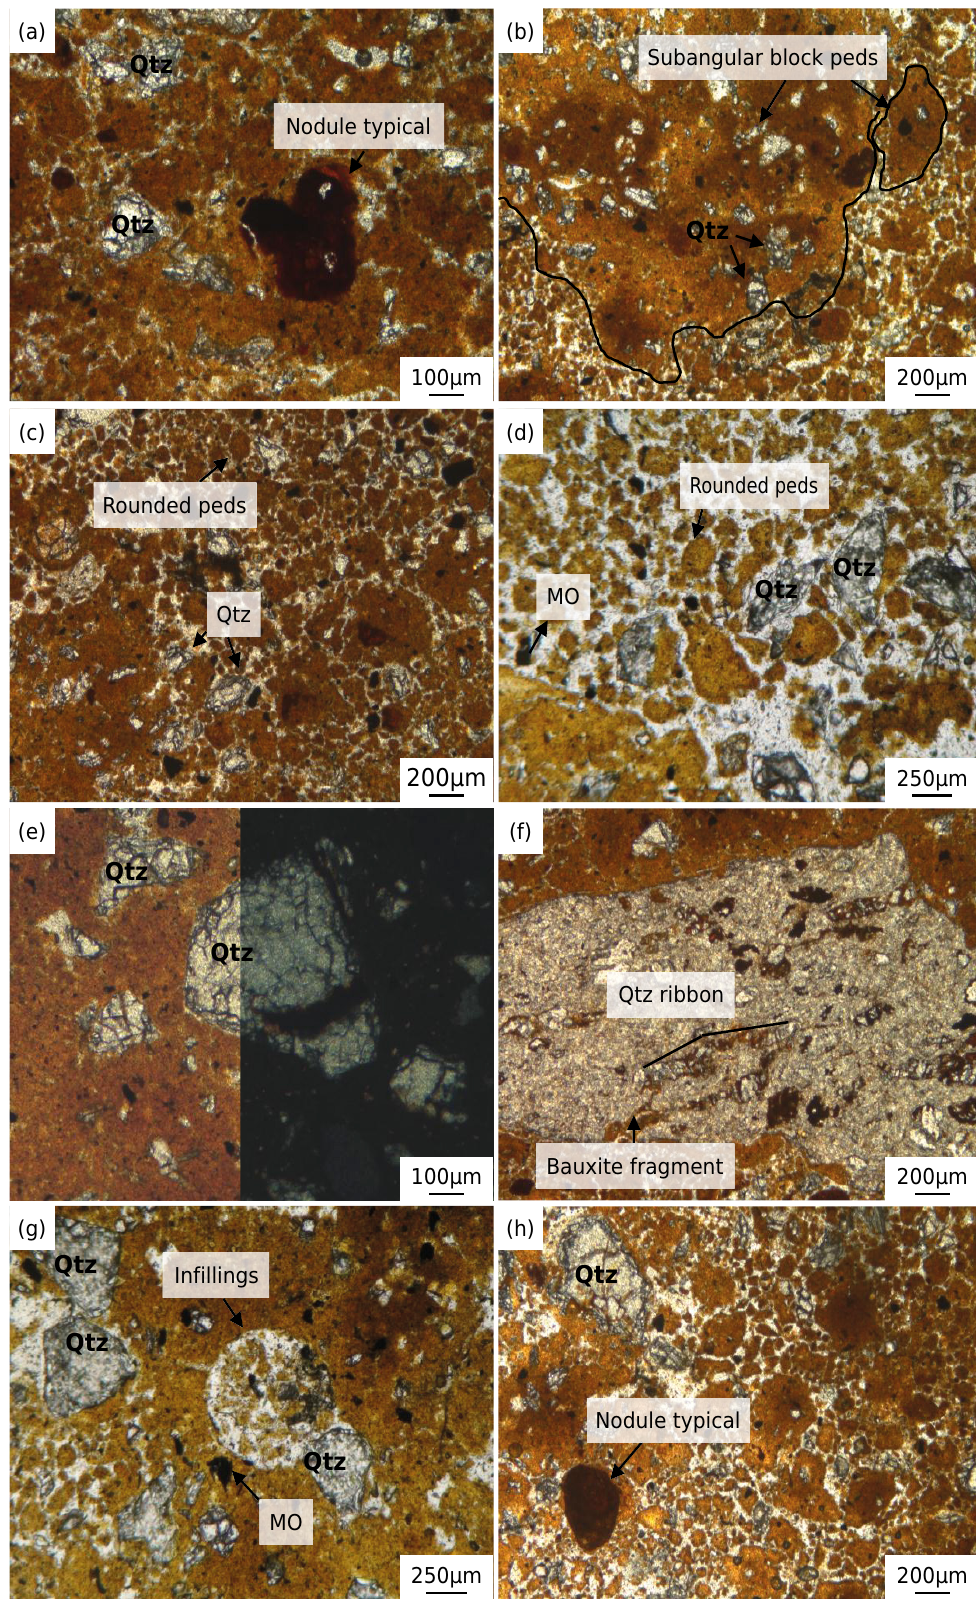
Figure 6. Photomicrograph of the Bw horizon. PPL: plane polarized light; XPL: crossed polarized light; Qz: quartz; OM: organic matter. (a) Subangular blocky microstructure. (b) Microaggregate microstructure with strongly separated rounded peds. (c) Microaggregate microstructure with strongly separated rounded peds and angular and subangular quartz. (d) Enaulic coarse/fine (c/f) related distribution with quartz grains that are separated in fine material. (e) Porphyritic c/f related distribution with angular quartz. The right side of the photomicrograph was taken under PPL and the left under XPL. (f) Bauxite fragment with ribbon. (h) Oxi-hydroxide typical nodules with an enaulic c/f related